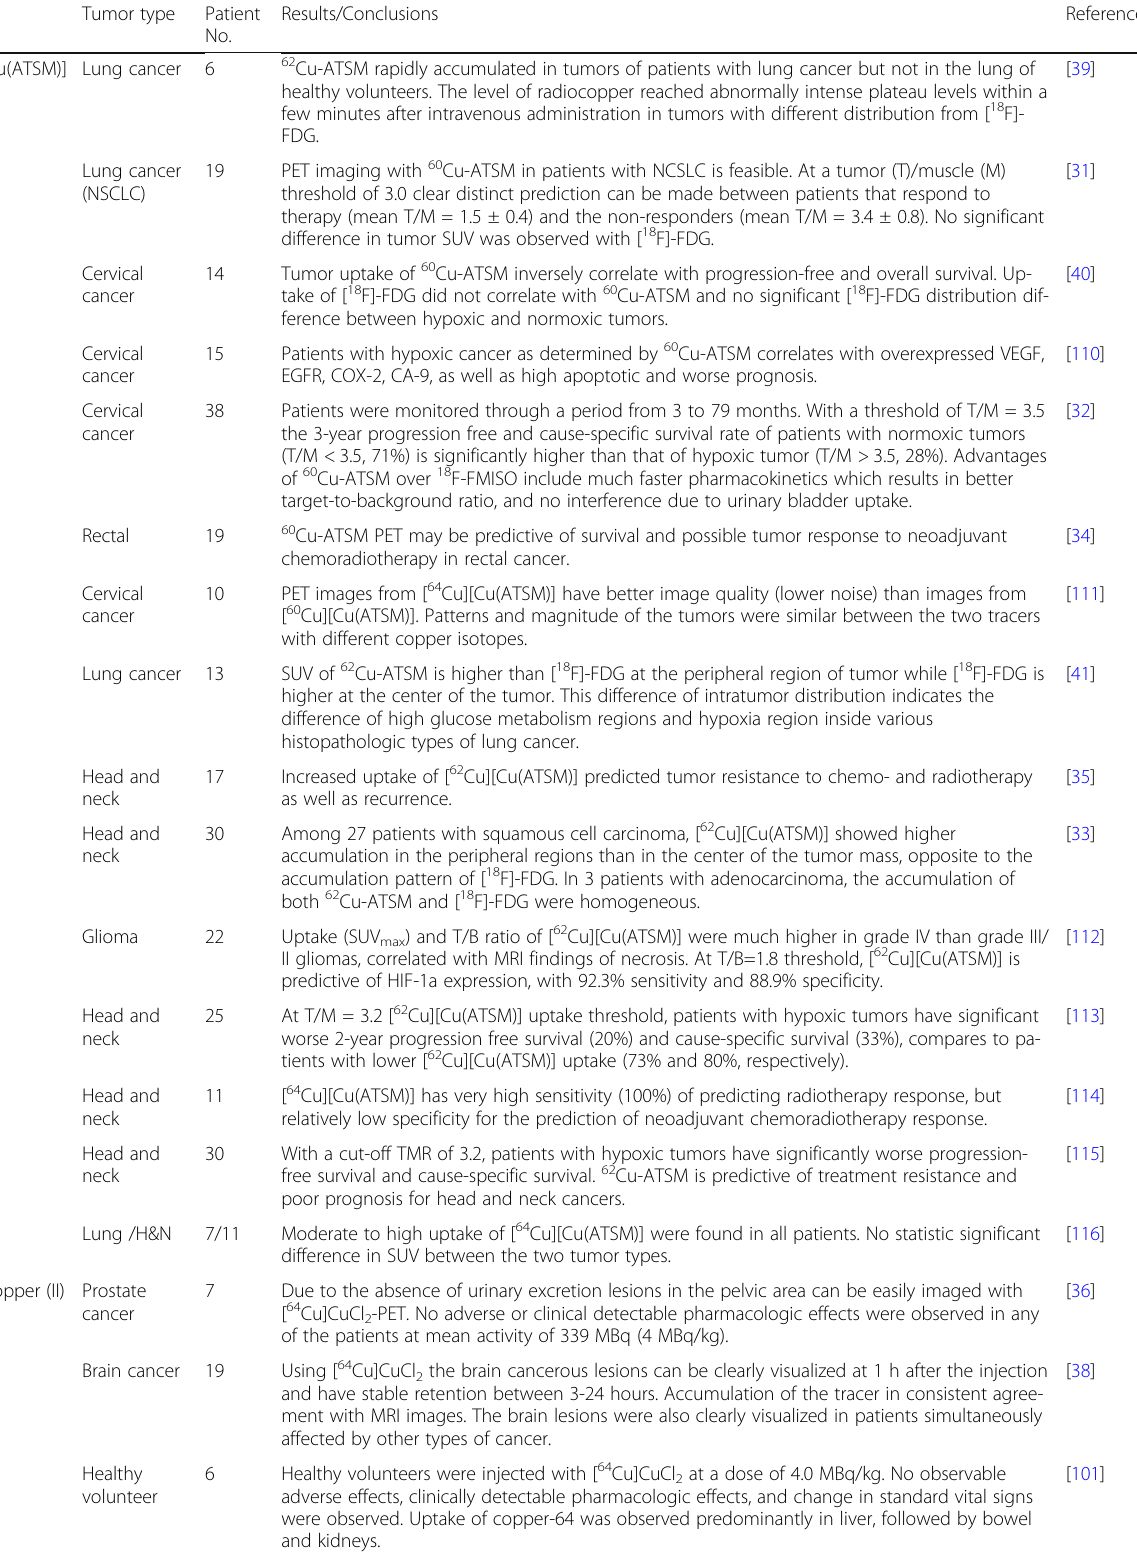
Table 1 Clinical studies using *copper(II)-diacetyl-bis(N4-methylthiosemicarbazone) ([ * Cu][Cu(ATSM)]) or *Cu-dichloride ([ * Cu]CuCl 2 ) as radioactive tracer in PET Tracer Tumor type Patient Results/Conclusions Reference No. [*Cu][Cu(ATSM)] Lung cancer 6